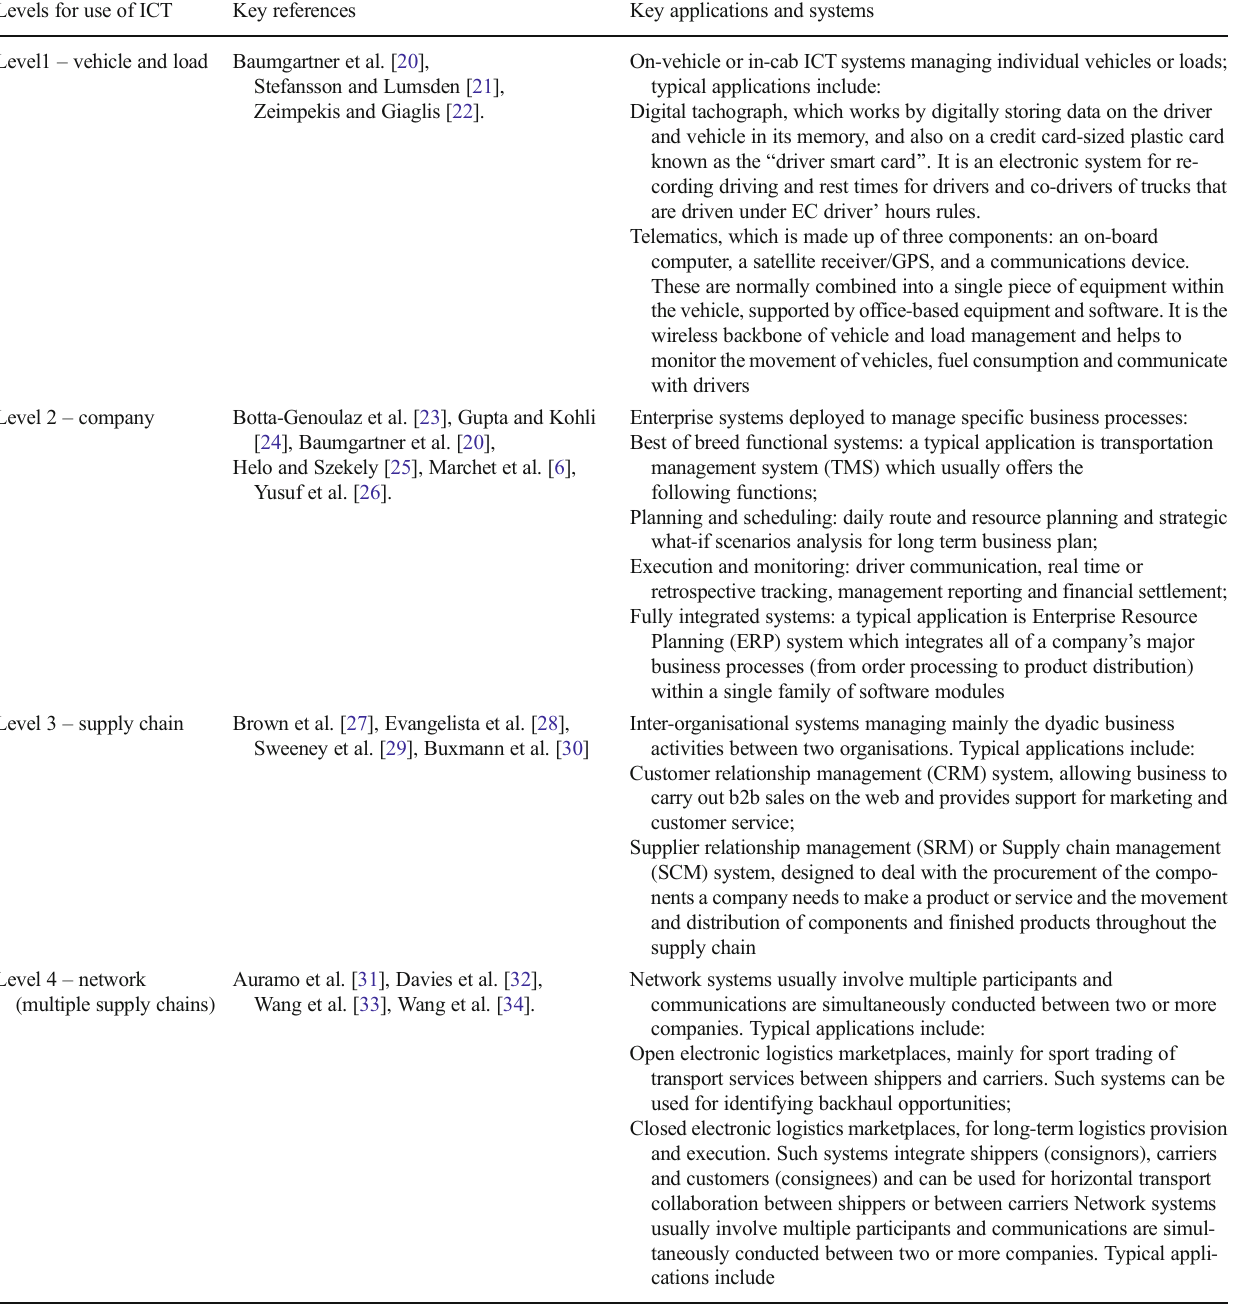
A hierarchical categorisation of ICT use in transport and logistics operations Levels for use of ICT Level1 – vehicle and load Baumgartner et al.